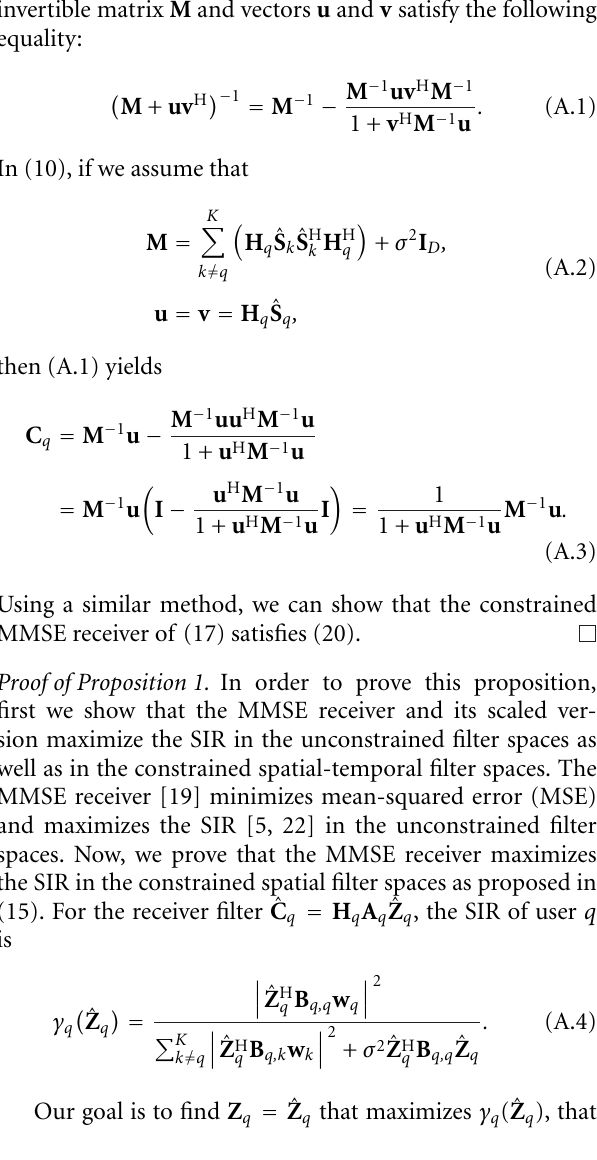
Figure 2: The relative performance of the algorithms is